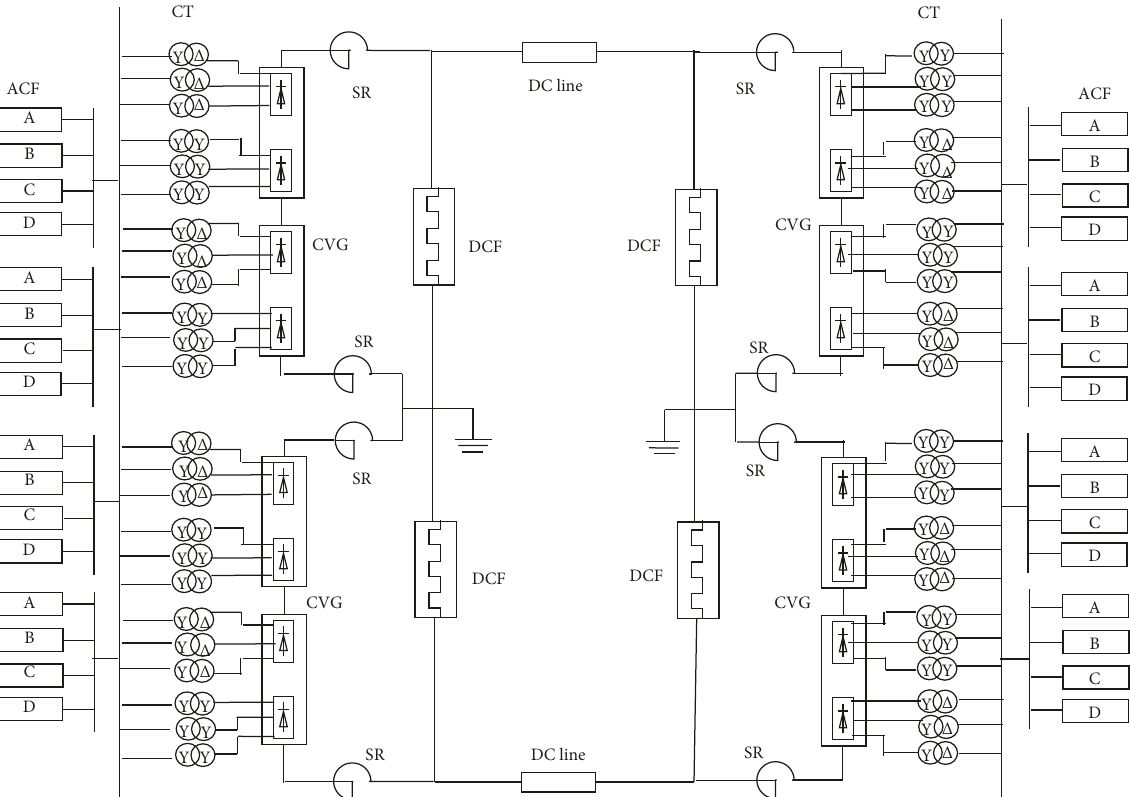
Figure 1: Schematic diagram of main electrical connection of UHVDC transmission. ACFs represent the AC filters; CTs represent the converter transformers; CVGs represent the 12-pulse converter valves groups; SRs represent the smoothing reactors; DCFs represent DC filters; and DC lines represent the DC transmission lines.